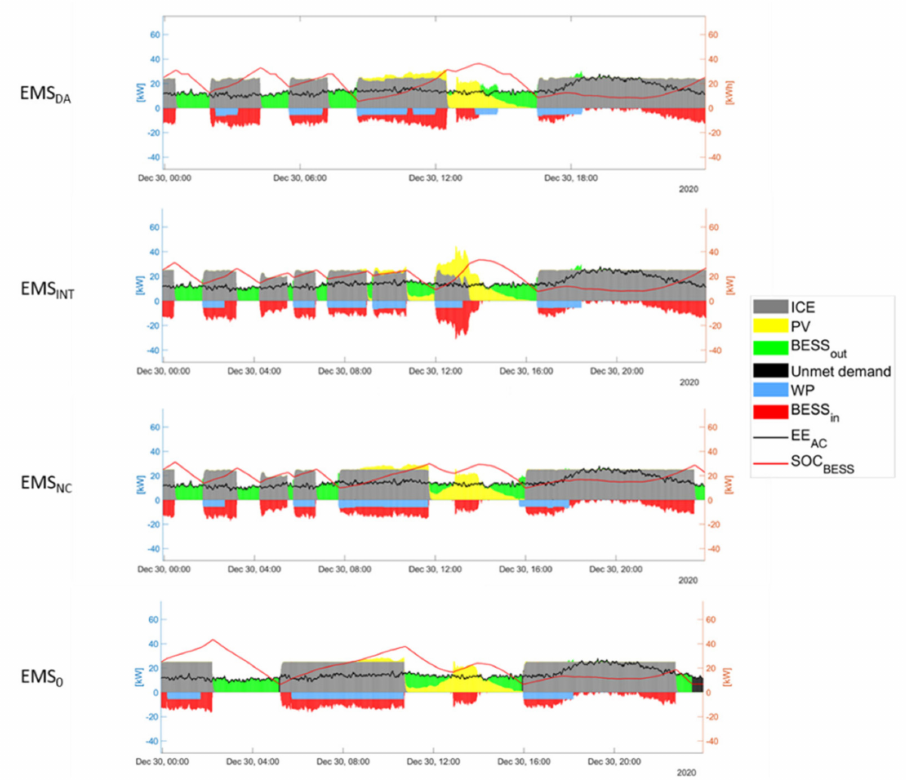
Figure 9. Microgrid dispatch comparison—day 1 ( EMS DA reflects the actual microgrid operation while the others are simulation